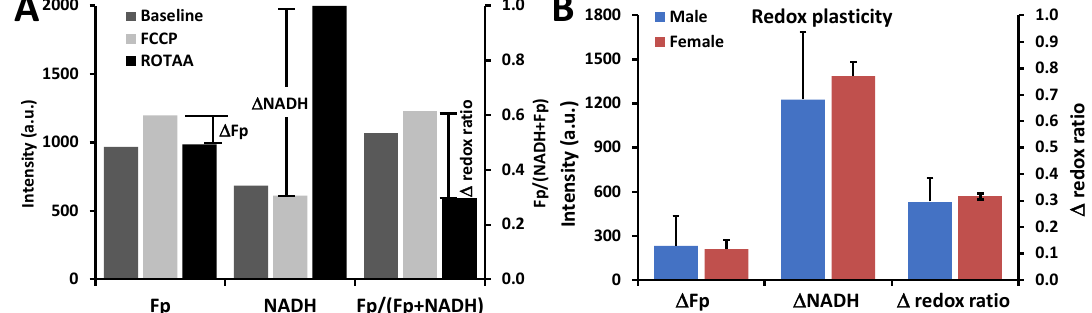
Figure 4. No significant sex-dependent difference in the redox plasticity of SP-A2 AM under the FA condition. ( A ) Illustration of calculations of redox plasticity, which is the difference between the oxidized (FCCP) and reduced (ROTAA) extremes of the redox indices. The calculation was first performed for AM from each mouse then averaged across the AM samples for each sex group; ( B ) Redox plasticity of AM from SP-A2 males and females (Mean ± SD).